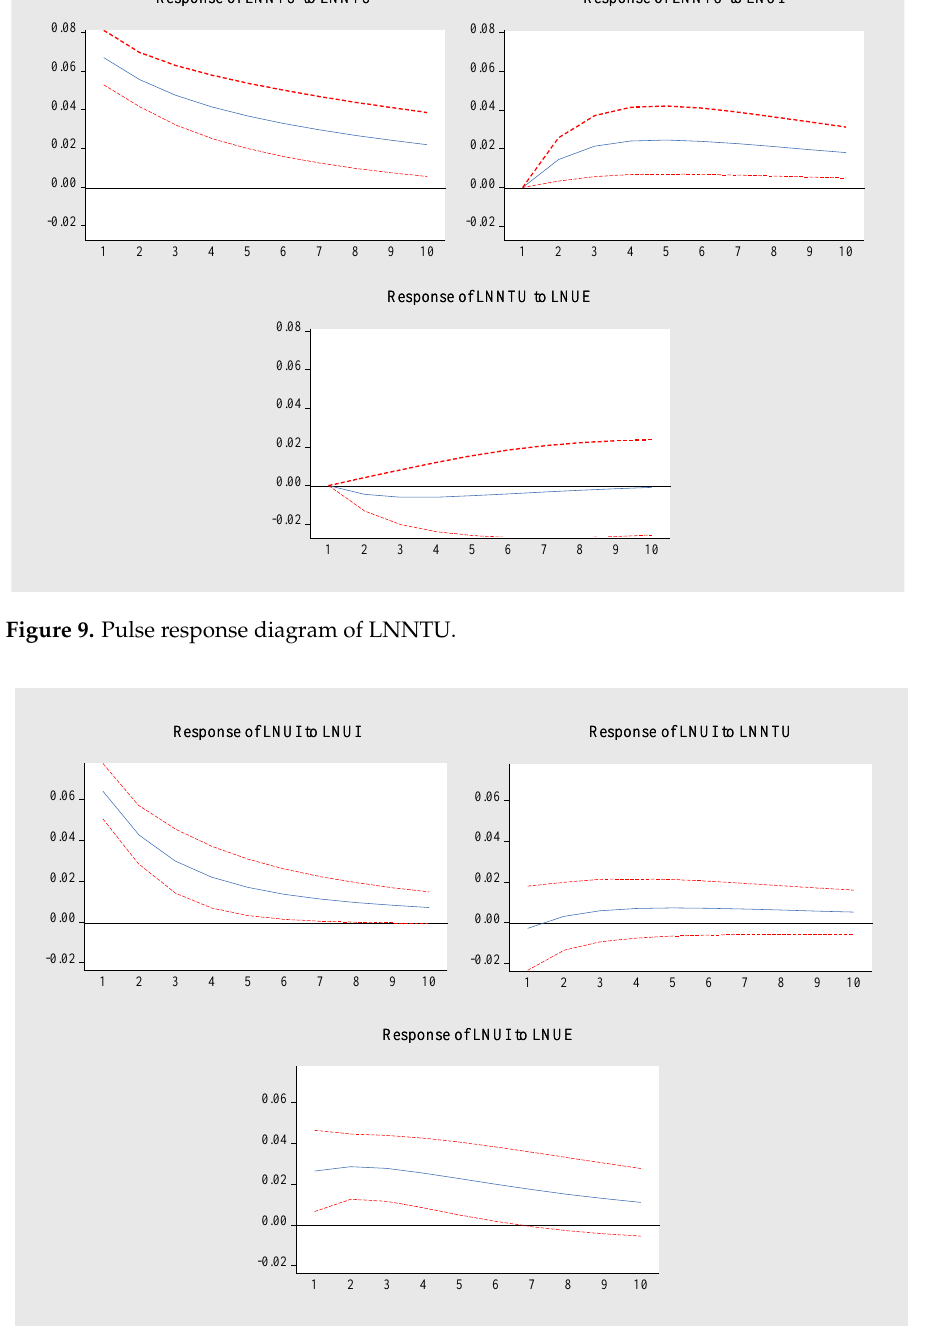
Figure 10. Pulse response diagram of